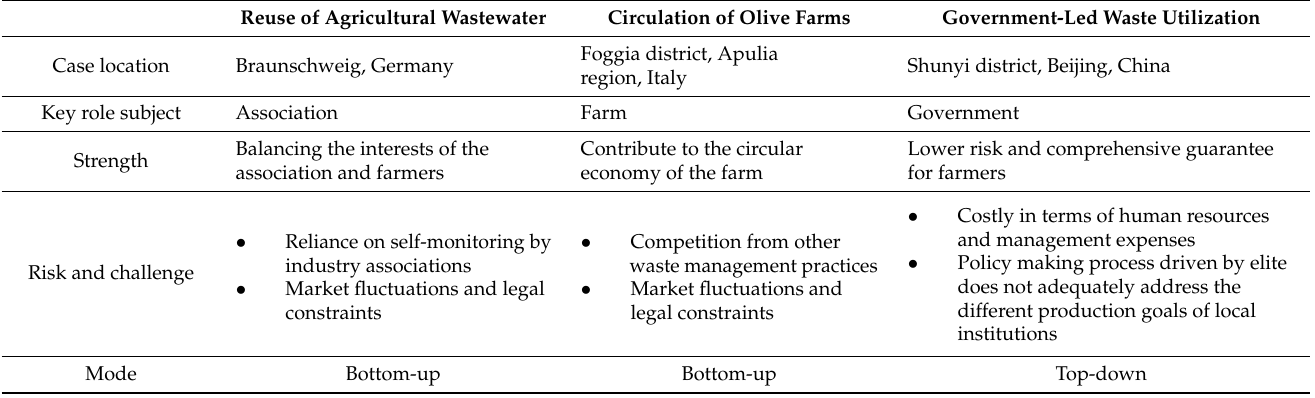
Table 1. Cases of Circular Agriculture under Different Political and Social